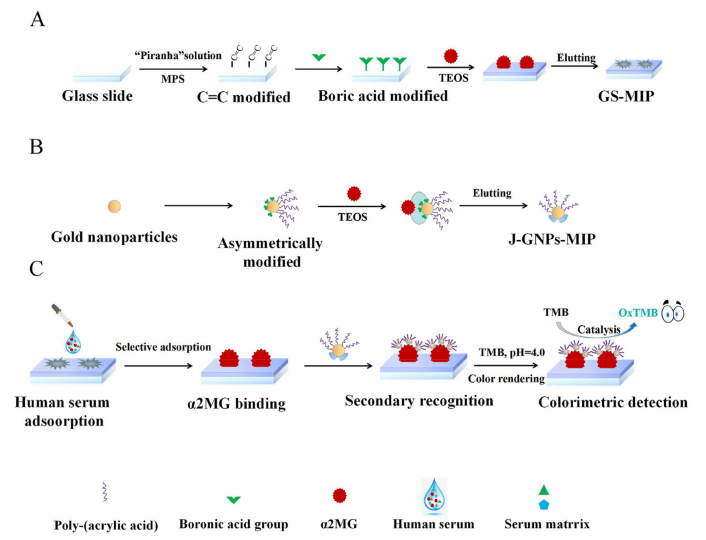
Figure 24. A synthesis scheme of the GS-MIP ( A ) and J-GNPs-MIP ( B ) and the detection mechanism of DMI-ICS ( C ). Reprinted with permission from ref. [215]. Copyright © 2022 Elsevier